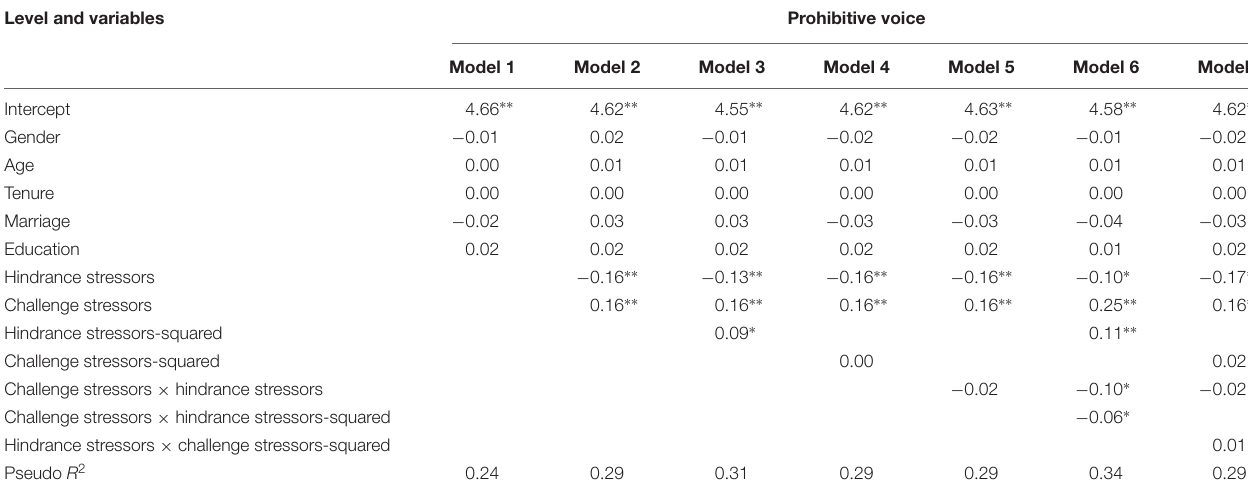
TABLE 3 | The relationship between stressors and prohibitive voice.